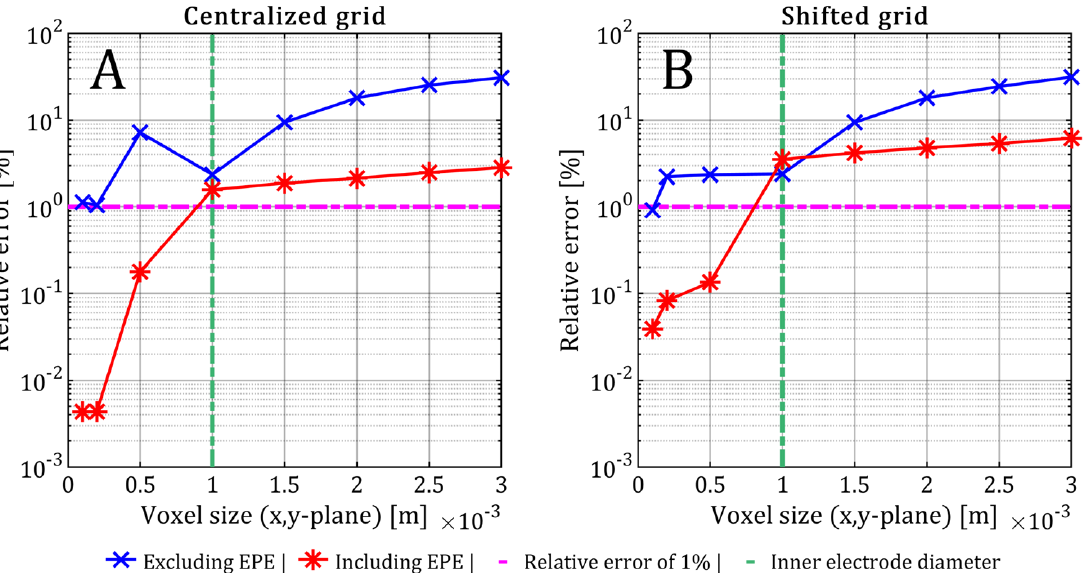
Figure 8. Relative error of the numerically calculated resistance values of the coaxial cable model with respect to the analytical resistance value as a function of voxel sizes for ( A ) centralized and ( B ) shifted grids.